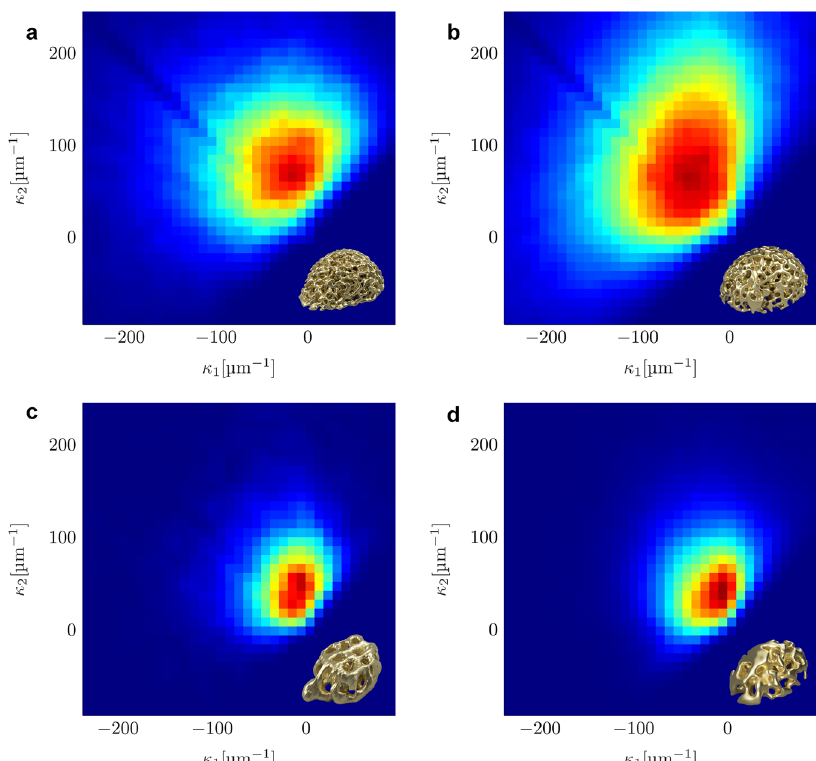
Fig. 4 ISDs of the principal curvatures of computer-generated and experimentally measured nanosponges. a Fine Reference Sponge b Fine Sponge S f ,2 c Coarse Reference Sponge, d Coarse Sponge S c ,1 . The visible gap around κ 1 = − κ 2 is an artifact of the discrete curvature evaluation. The bins are sized 10 μ m − 1 by 10 μ m − 1 and the distributions are normalized to their maximum